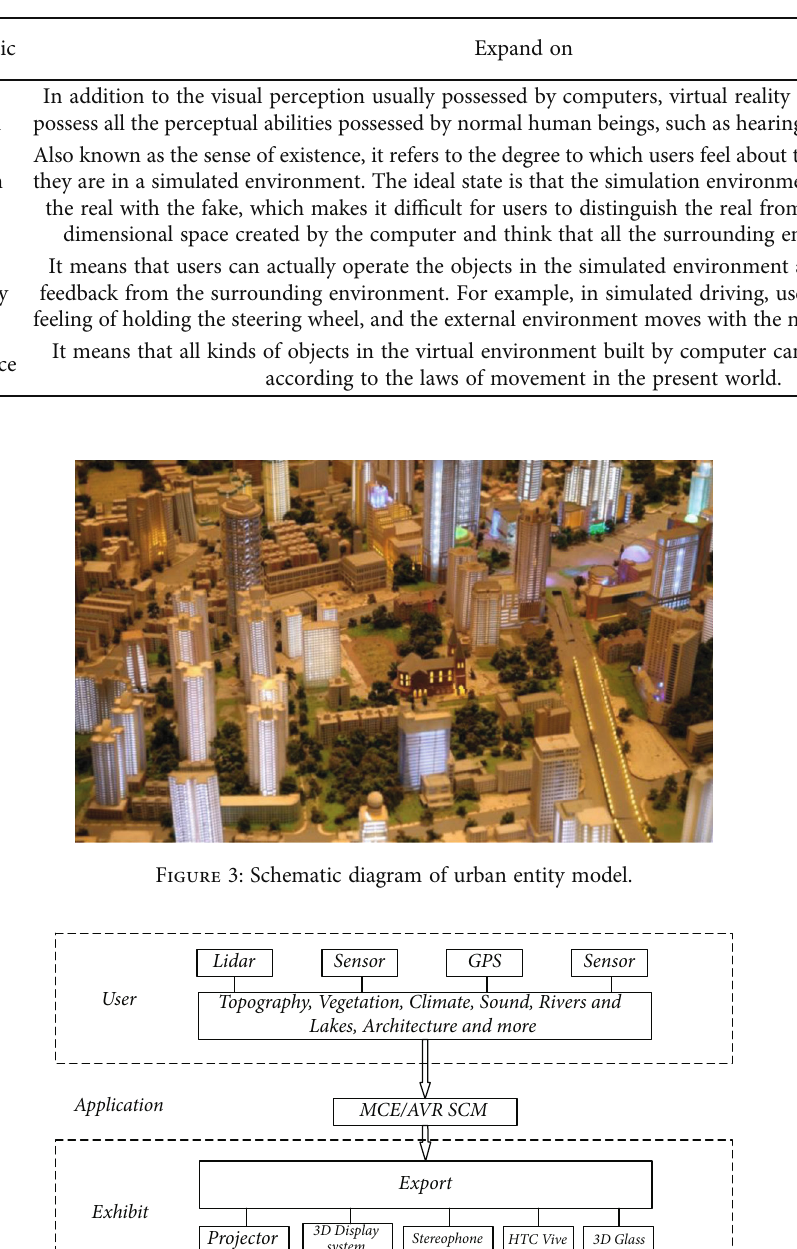
Table 1: Main features of virtual reality technology.